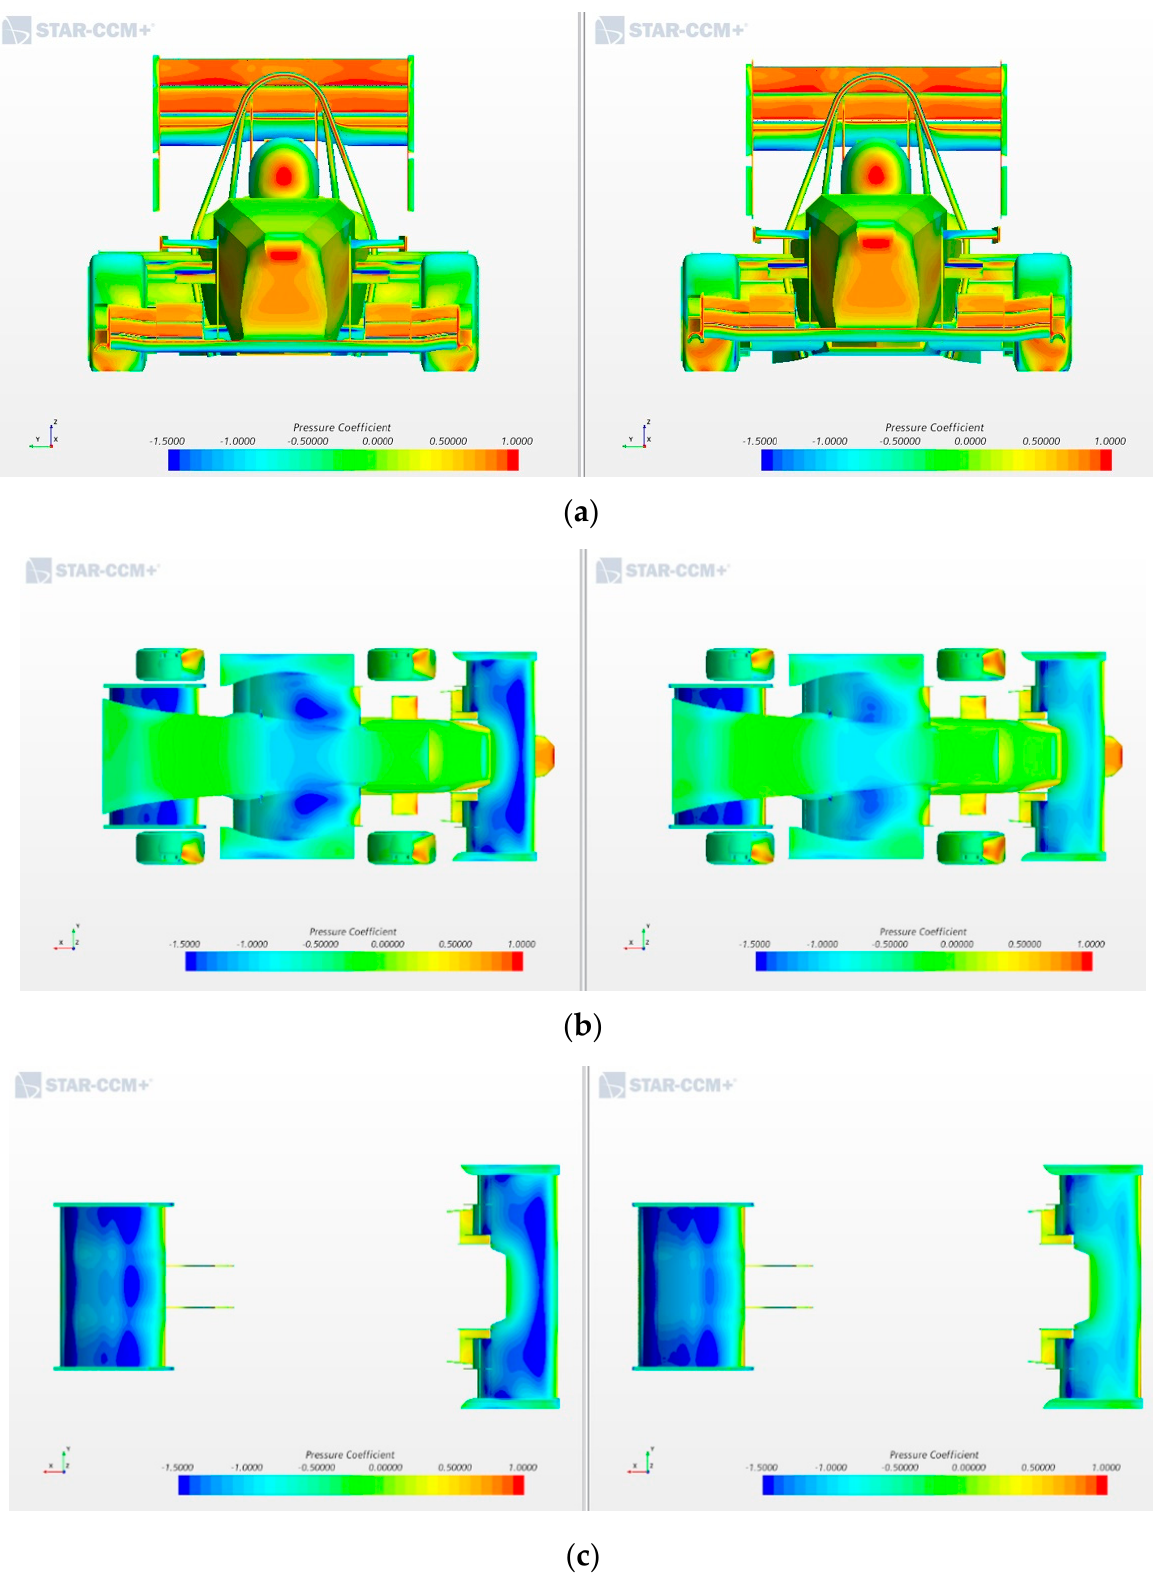
Figure 9. Comparison of pressure cloud images of racing cars in pitching condition of − 1.0 ◦ ( left ) and 0.5 ◦ ( right ): ( a ) the main view of the vehicle, ( b ) the vehicle and ( c ) the front wing and the side wing.